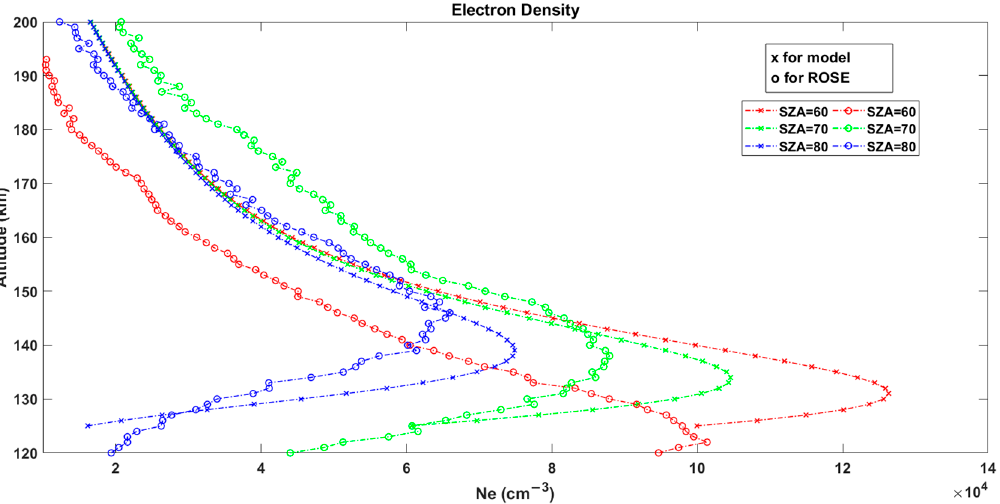
Figure 3. Variations of electron density profiles, with SZAs estimated by the model (marked with “x”) and from ROSE on MAVEN (marked with “o”).